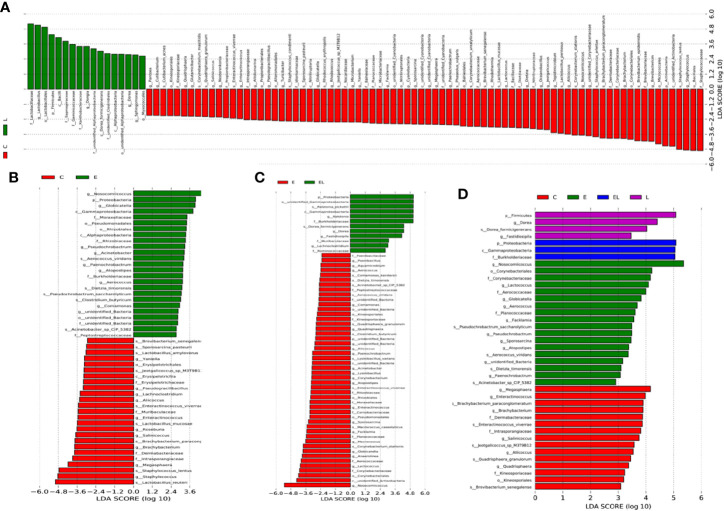
The differences in abundance between the different groups were evaluated using LDA scores. (A) The differences in abundance between the C and L groups. (B) The differences in abundance between the C and E groups. (C) The differences in abundance between the E and EL groups. (D) The differences in abundance between the C, E, EL and L groups. LDA scores > 2 was considered statistically significant.